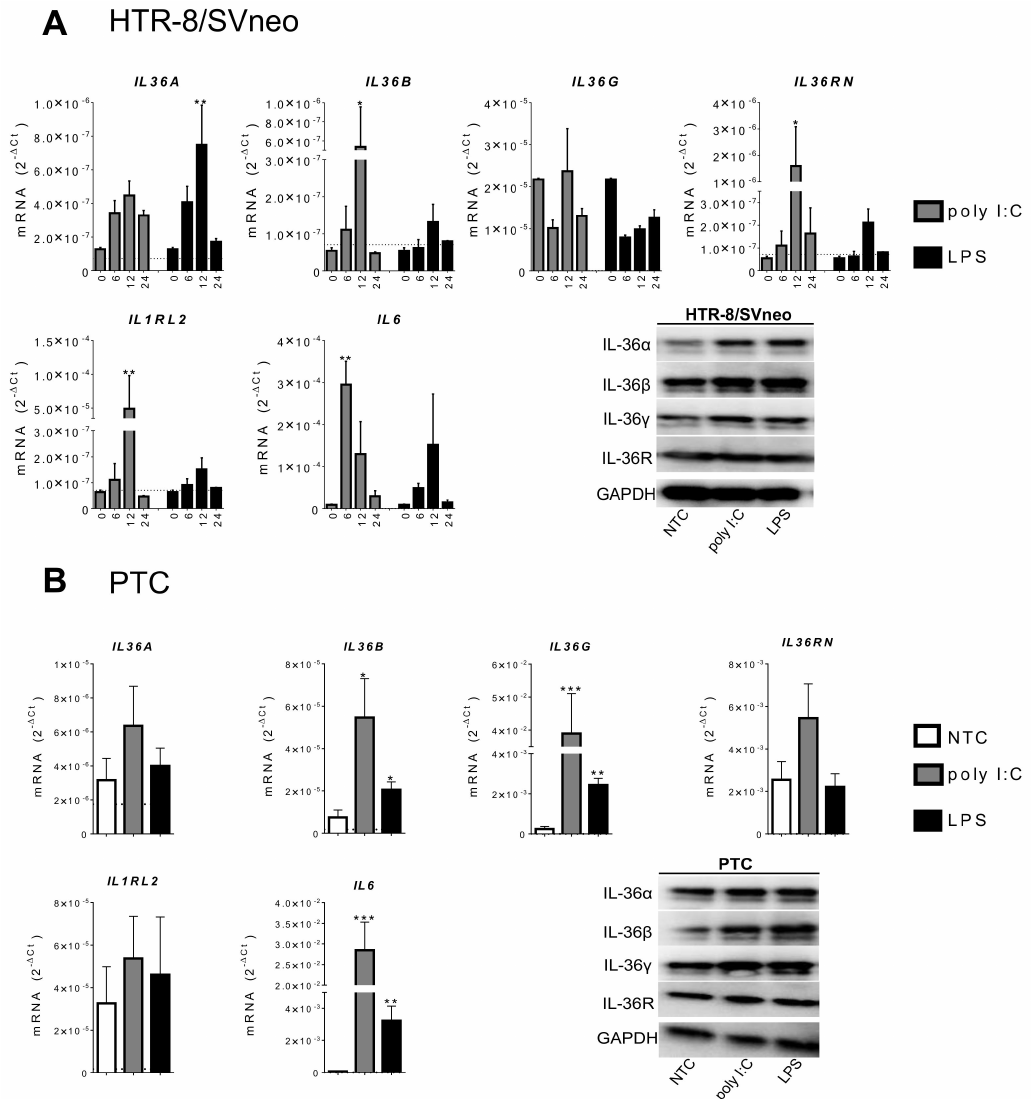
Figure 2. IL-36 expression induced by poly I:C and LPS in HTR-8/SVneo cells and primary trophoblast cells (PTC). ( A ) HTR-8/SVneo cells were stimulated with 25 µ g/mL of poly I:C or 100 ng/mL of LPS for 6, 12, and 24 h. ( B ) PTC were stimulated under the same conditions for 12 h. mRNA levels were determined by qPCR and normalized using the 2 − ∆ Ct method to GAPDH. The horizontal dotted lines denote detection limit (Ct > 40; if not visible it overlaps with the x-axis). Results from three independent experiments are shown as mean ± SEM. One-way ANOVA with Dunnett’s multiple comparison test. * p < 0.05, ** p < 0.01, *** p < 0.001 against the respective 0 h or NTC control. Additionally, in ( A , B ), bands show representative Western blotting for detection of IL-36 ( α , β , γ ), IL-36R, and GAPDH by using 20 µ g cell lysate from HTR-8/SVneo and PTC stimulated for 12h. NTC: Non-treated